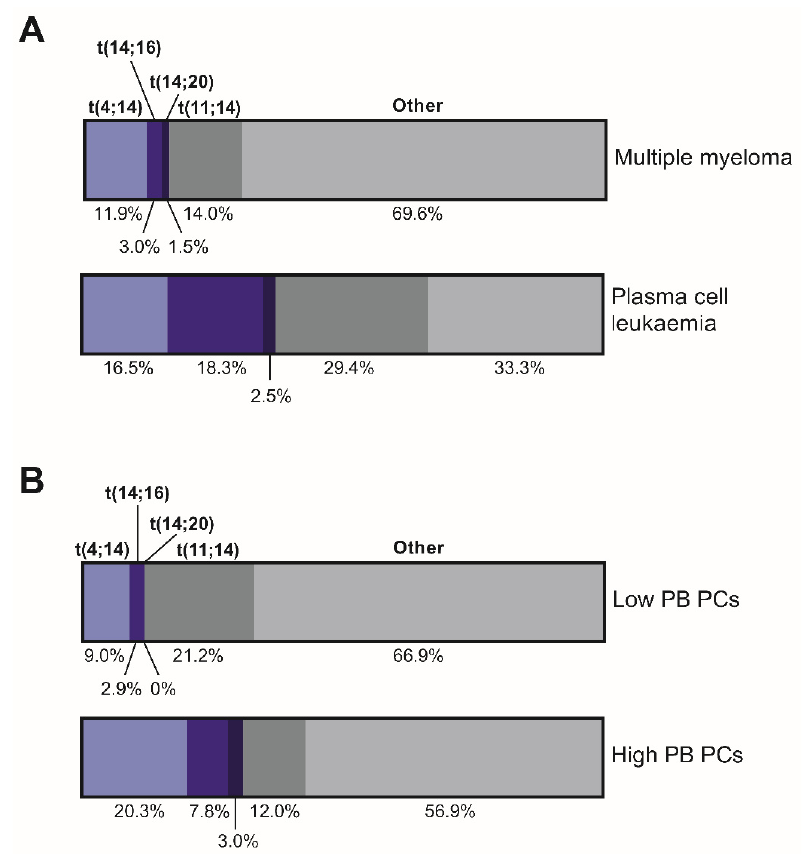
Figure 3. High-risk cytogenetics are associated with higher numbers of circulating multiple myeloma (MM) plasma cells (PCs) in patients. Average proportion of MM and plasma cell leukaemia (PCL) patients with common IgH translocation t(4;14), t(14;16), t(14;20) or t(11;14), or those without these translocations (other), are shown. Data is shown for patients with newly diagnosed MM or PCL ( A ) or for newly diagnosed MM patients with low or high circulating MM PC numbers ( B ). Higher incidences of high-risk cytogenetics t(4;14), t(14;16) and t(14;20) is observed in patients with PCL and in patients with high numbers of MM PCs in the peripheral blood (PB). Data is taken from [107–111] ( A ) and [11,14,113] ( B ).